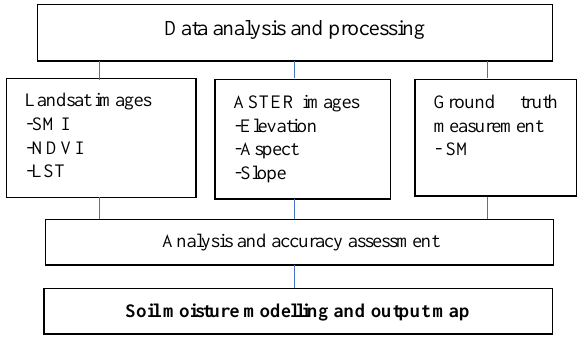
Figure 3. Method schema